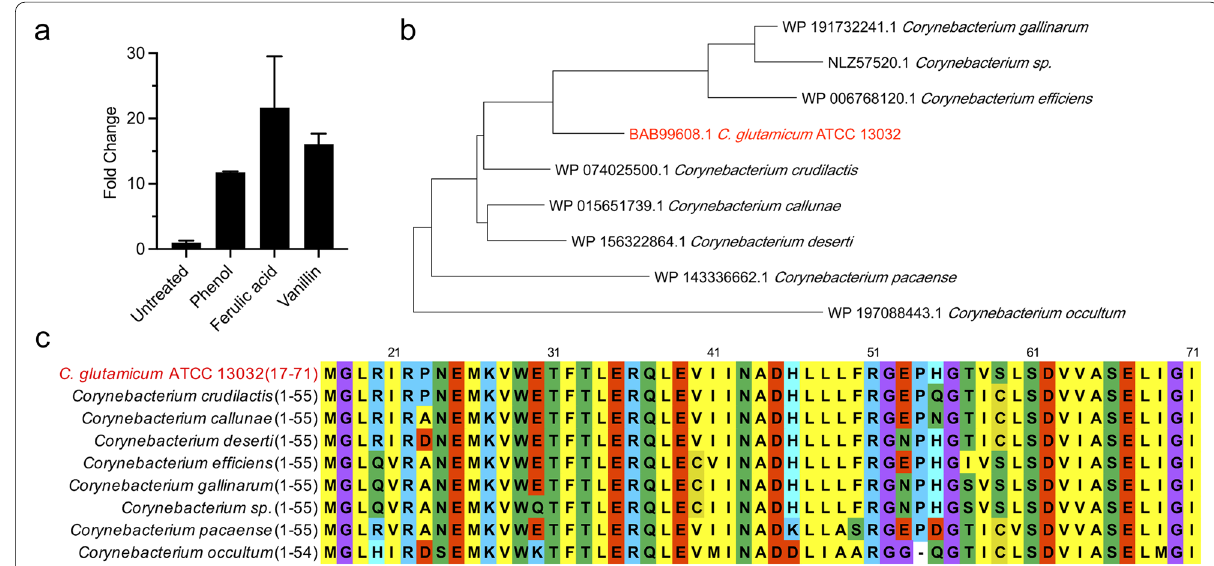
Fig. 1 cgl2215 transcription in C. glutamicum in response to phenolic compounds and bioinformatics analysis of Cgl2215 protein . a qRT-PCR analysis of cgl2215 transcription in C. glutamicum exposure to phenol (4 mM), ferulic acid (3 mM), or vanillin (3 mM) stresses. b Phylogenetic tree analysis of Cgl2215 and its homologs. C Multiple-sequence alignment analysis of Cgl2215 and its homologs